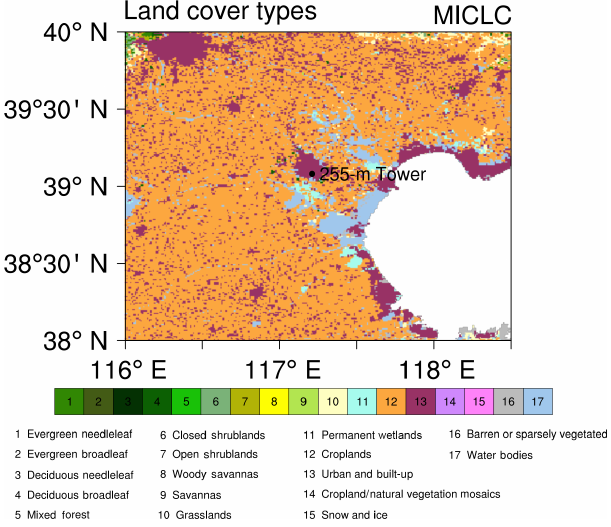
Figure 1. Land use map around the site. The black dot denotes the location of the 255m meteorological observation